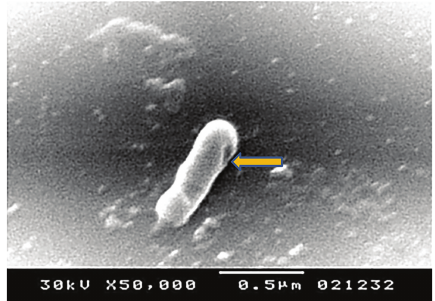
Figure 6: Electron microscope for the STGs at 15000x.